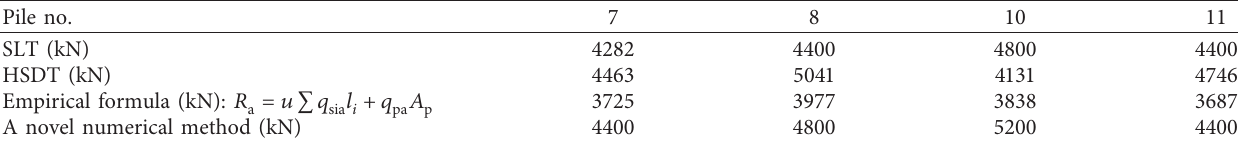
Table 12: Results of numerical simulation and experimental testing of test piles at the hard rock bearing stratum site. Pile